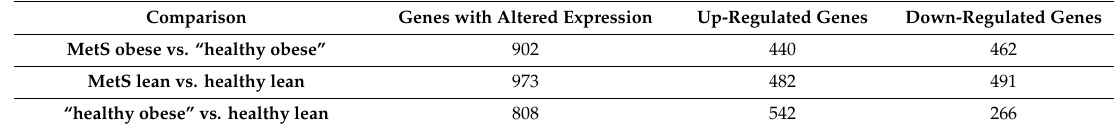
Table 2. Filtering summary for all